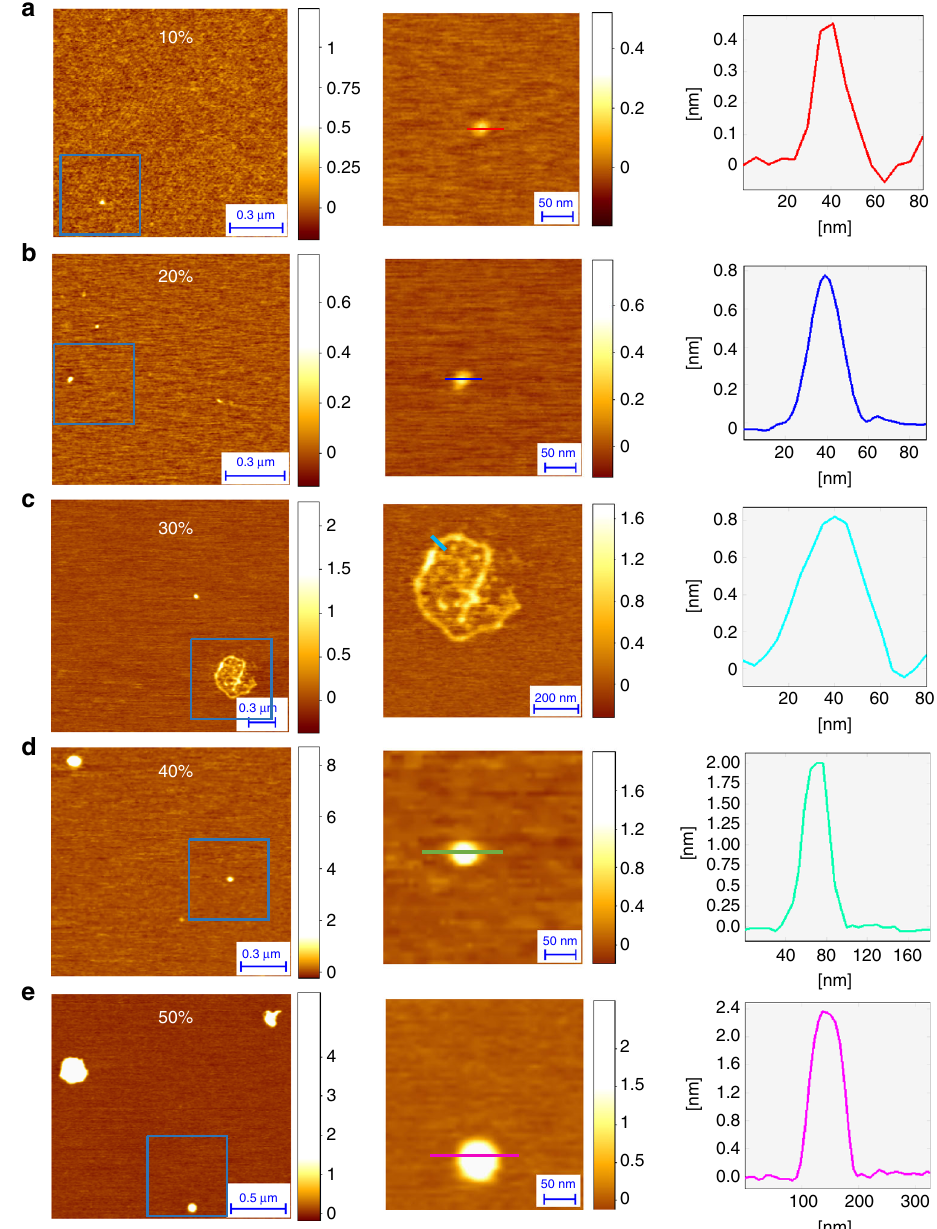
Fig. 3 AFM characterization of aggregates present in sucrose fractions. a – e Representative AFM images of the A β 42 aggregates present at different fractions of sucrose gradient (left panels), with a magni fi ed example of the species present in each fraction (central panel) and the corresponding cross- sectional dimensions (right panel). The 30% fraction ( c ) is the only one that shows proto fi laments